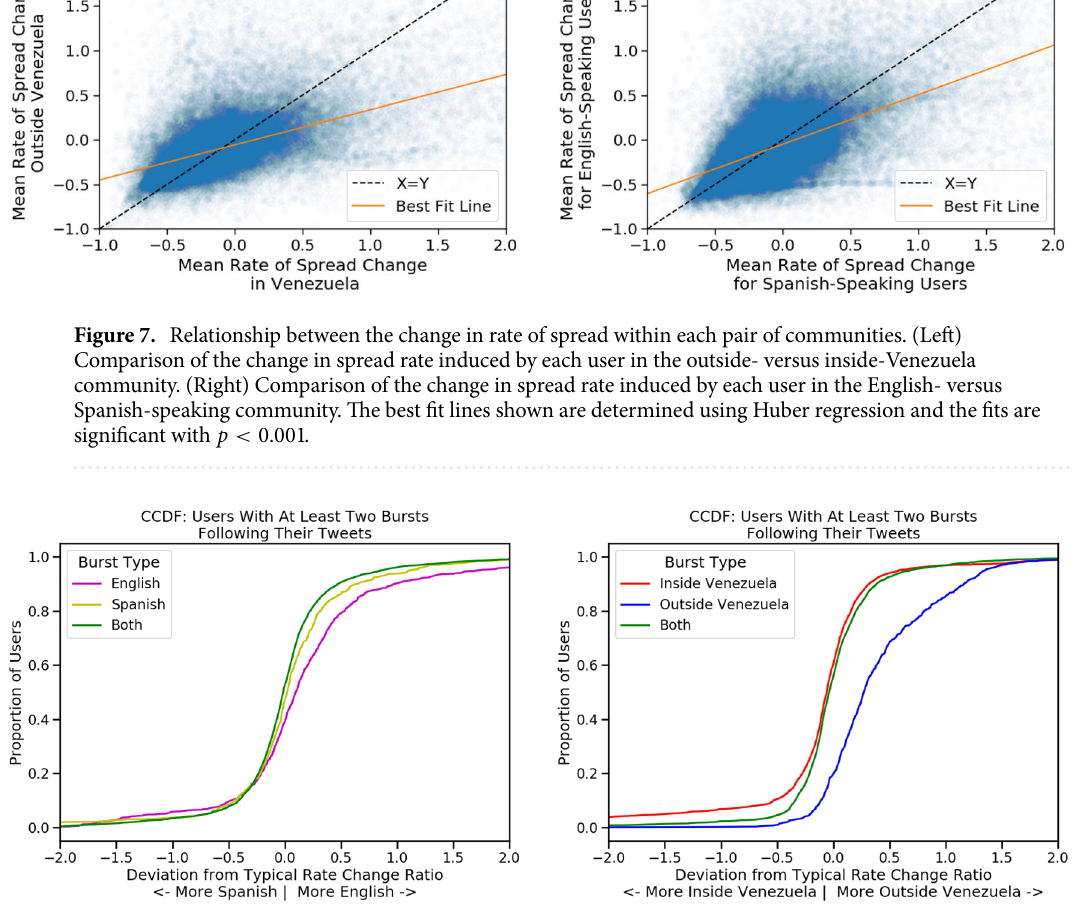
Figure 8. CCDF of the user deviations from the typical ratio of rate changes between communities (distance from the best fit line in Fig. 7) for users with at least two burst-preceding tweets for bursts occurring (left) only in the Spanish-speaking community (yellow), only in the English-speaking community (purple), or across both communities (green); and (right) only in the inside-Venezuela community (red), only in the outside-Venezuela community (blue), or across both communities (green).